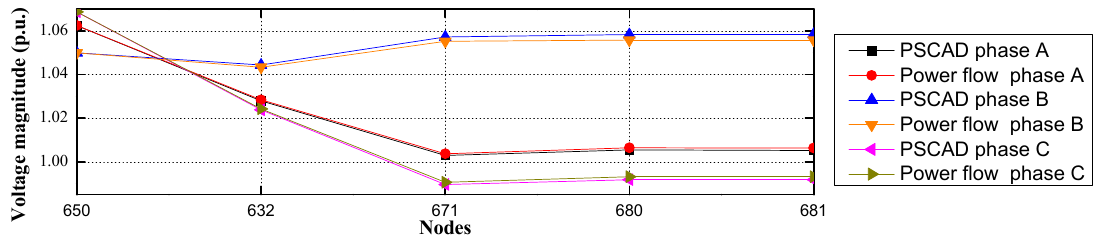
Figure 9. Voltage profile of the nodes on the path from the secondary side of the voltage regulator to the DG-connected node when the active power output of the DG was 1000